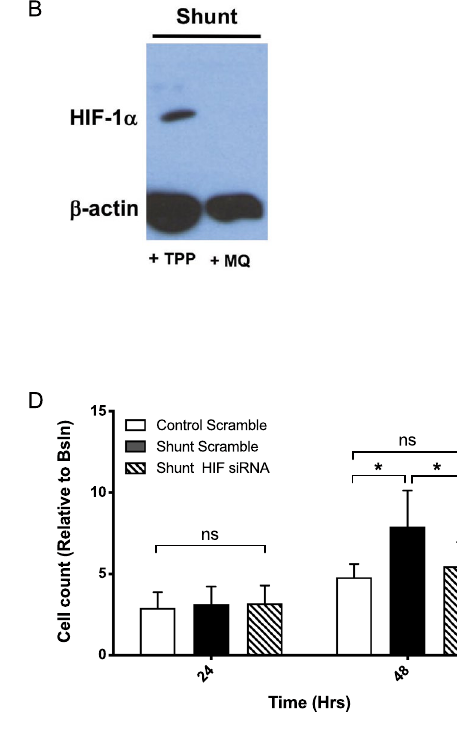
Figure 4. Mitochondrial ROS stabilize HIF-1α and drive HIF-1α-dependent proliferation in shunt LECs. ( A ) HIF-1α protein is significantly stabilized in sheared (s) control LECs compared with non-sheared (ns) controls; treatment of sheared control LECs with a mitochondrially targeted antioxidant mitoquinone (s + MQ) abrogates HIF-1α protein stabilization, *, P < 0.05, N = 3 control no shear compared with 3 control + shear; †, P < 0.05, N = 3 control + shear compared with 3 control + shear + MQ; ( B ) Treatment of shunt LECs with MQ abrogates HIF-1α expression but does not with triphenylphosphonium (TPP), a lipophilic cationic control; NB, each lane is a pooled sample of 3 distinct shunt LEC lines. ( C ) At 72hrs, treatment of shunt LECs with MQ (angled line bar) slows proliferation to the level observed in control LECs, P > 0.05, whether untreated, + MQ, or + TPP (white, speckled, and inverted caret bars, respectively); *, P < 0.05 compared to untreated shunt LECs (black bar). Treatment of shunt LECs with TPP (solid gray bar) does not change proliferation compared to untreated shunt LECs (black bar), and remains significantly faster than control LECs or shunt LECs treated with MQ, #, P < 0.05. N = 3 control, 3 shunt, for each condition: untreated, + TPP, and + MQ. NB, cell counts normalized to baseline 24 hr timepoint. ( D ) Knockdown of HIF-1α in shunt LECs (angled line bars) slows proliferation to levels observed in scramble treated controls (white bars), *, P < 0.05 comparing scramble treated control and shunt LECs, or scramble treated shunt LECs and siHIF-1α treated shunt LECs; N = 3 control + scr, 3 shunt + scr, 3 shunt + siHIF-1α. In panels A, C and D, error bars represent standard deviation. For panels A and B, full-length blots/gels are presented in Supplemental Fig.